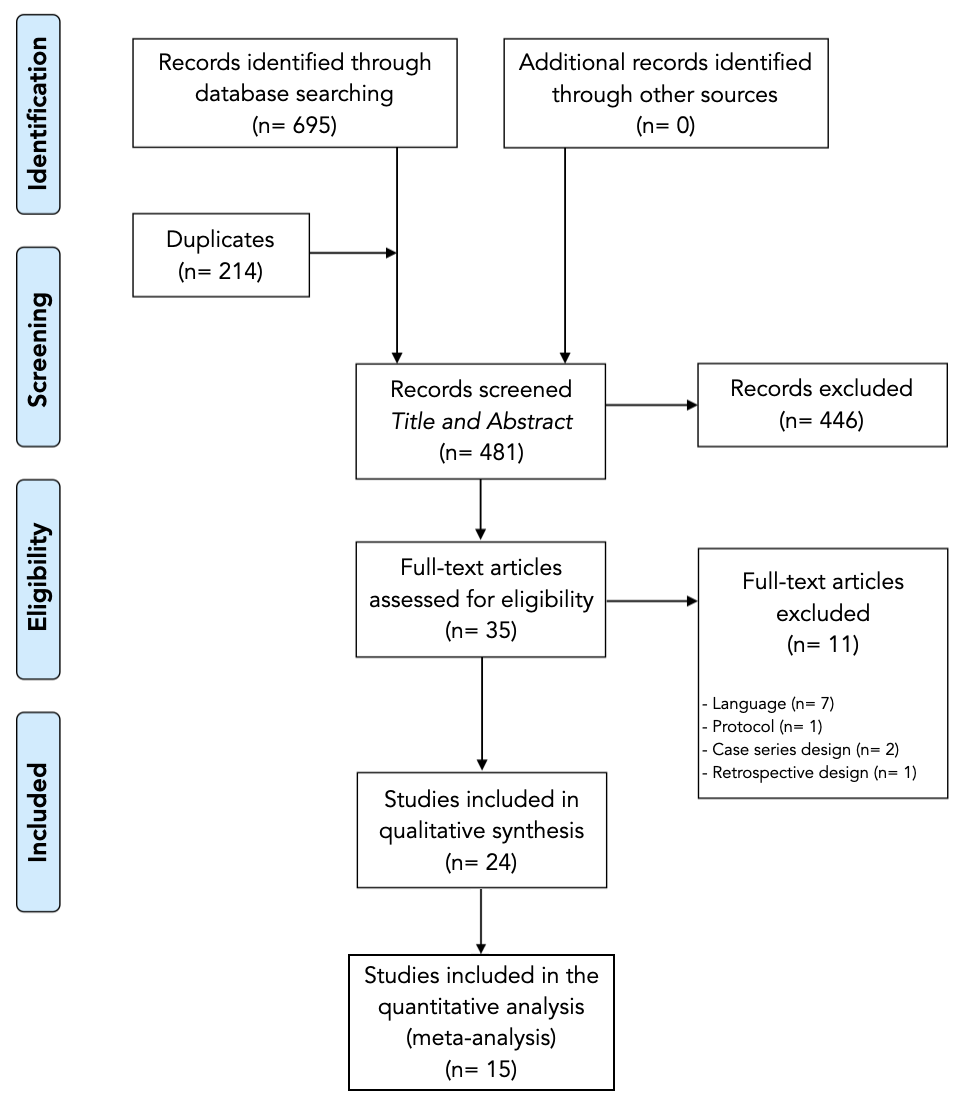
Figure 1. Preferred Reporting Items for Systematic Reviews and Meta-Analyses Flowchart.